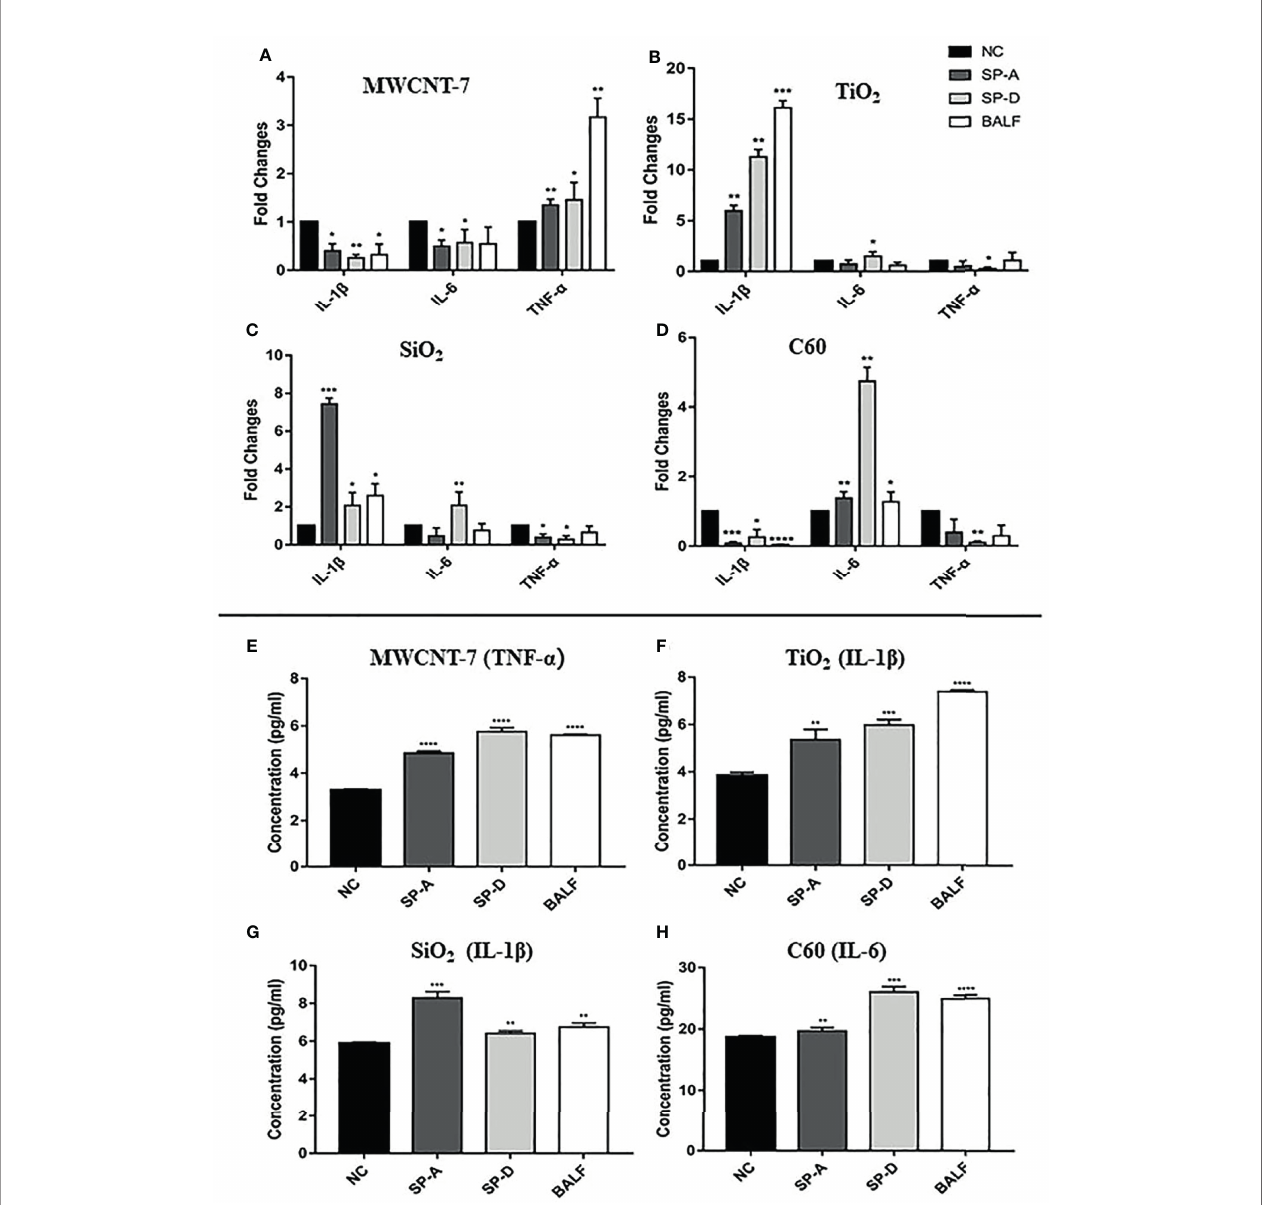
FIGURE 4 | Effects of SP-A and SP-D on cytokine production. Rat primary alveolar macrophages in X-VIVO ™ serum-free medium were treated with the vehicle; or 1 m g/ml MWCNT-7, TiO m g/ml of recombinant human SP-A, SP-D, or 10% concentrated m g/ml MWCNT-7, TiO 2 , SiO 2 , or C60; or 1 2 , SiO 2 , or C60 pre-incubated with 1 BALF, and cultured for 12 hours. The RNAs isolated from the treated cells were analyzed by qPCR for expression of TNF- a , IL-1 b and IL-6 (A – D) . The culture media was collected and used for ELISA detection of TNF- a , IL-1 b , and IL-6 (E – H) . (A, E) treatment with MWCNT-7. (B, F) , treatment with TiO 2 . (C, G) , treatment with SiO 2 .D and H, treatment with C60. *, **, *** and **** p values less than 0.05, 0.01, 0.001, and 0.0001, respectively, compared with the negative control